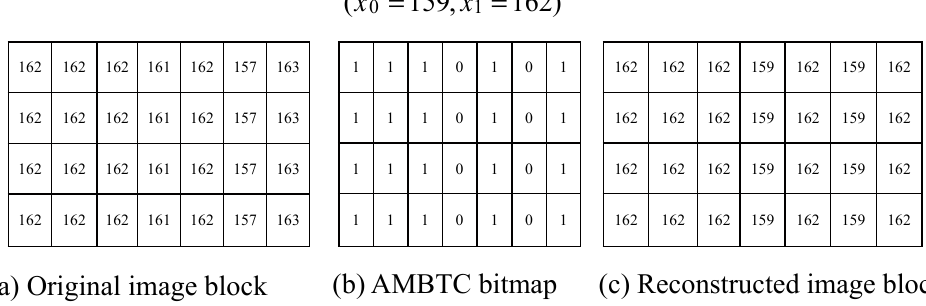
Figure 1. Example of AMBTC compression with 4 × 7 block.